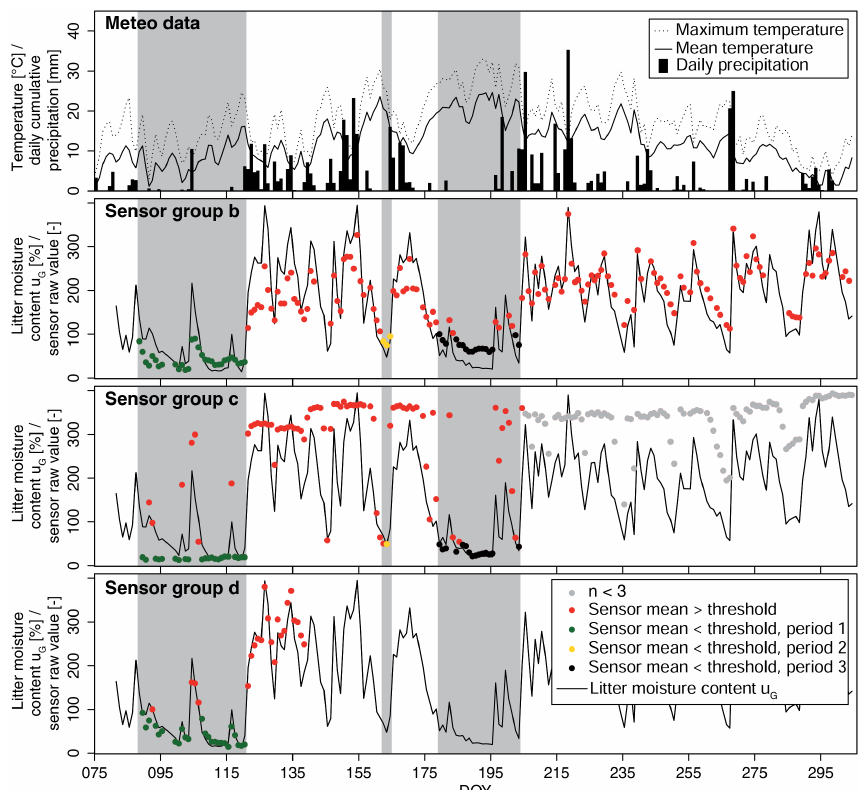
Figure 4. Meteorological data and litter moisture content ( u G ), as well as rescaled sensor mean values during the study period. Colored dots indicate sensor mean values: calculated from less than three sensors (gray), beyond the threshold set in Fig. 6 (red), below the threshold and part of period 1 (green), below the threshold and part of period 2 (yellow) and below the threshold and part of period 3 (black). The gray areas correspond to periods 1–3 defined in Sect.